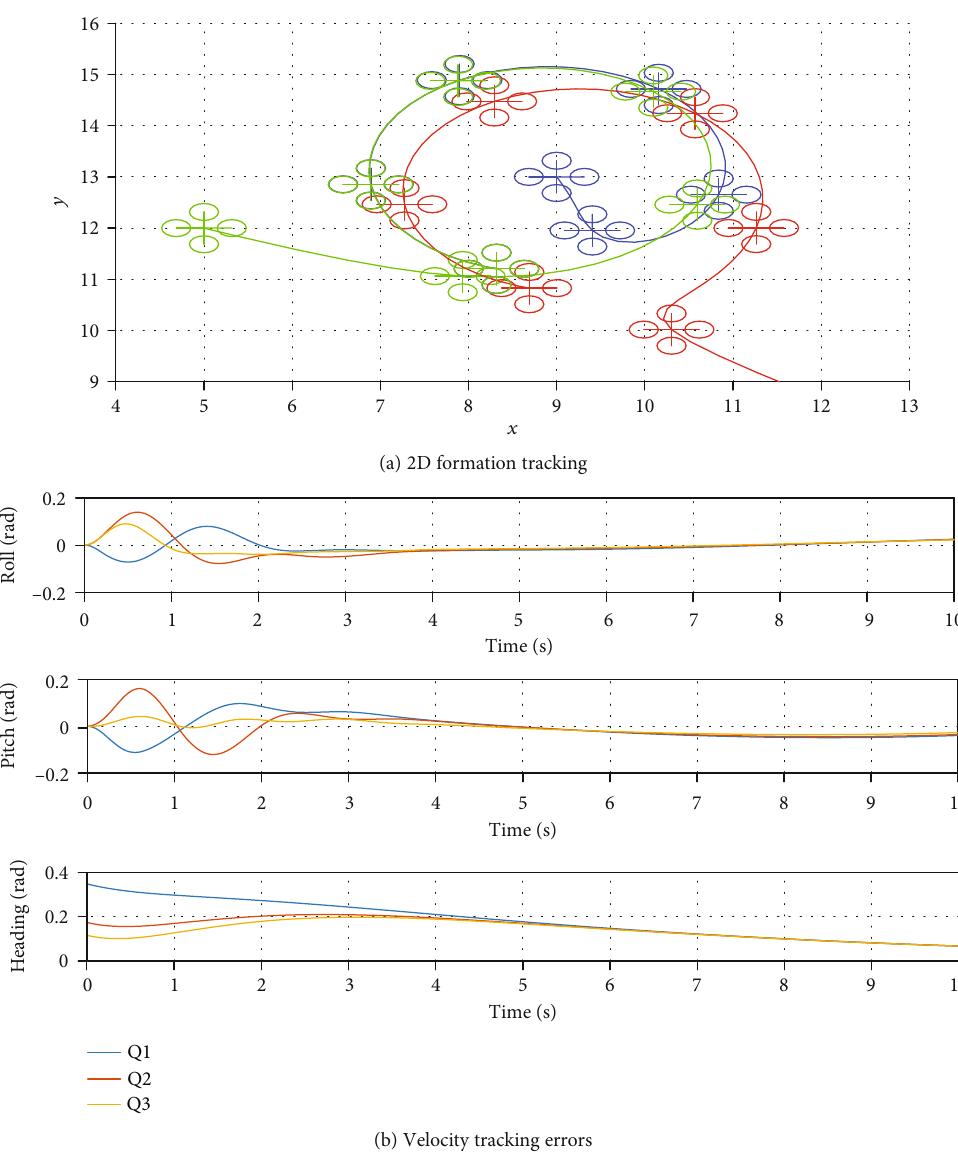
Figure 7: Convergence of the backstepping state tracking